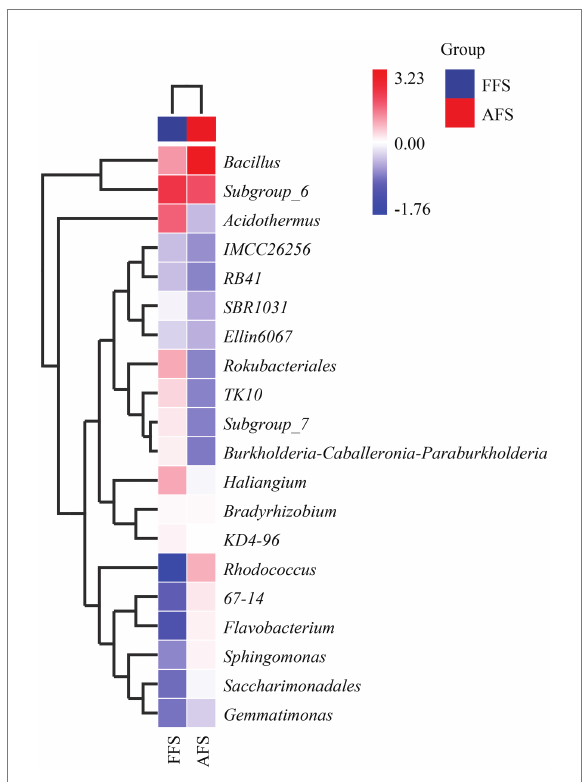
FIGURE 5 The heatmap of top 20 clusters for species abundance (Genus) in the SFS and the AFS.